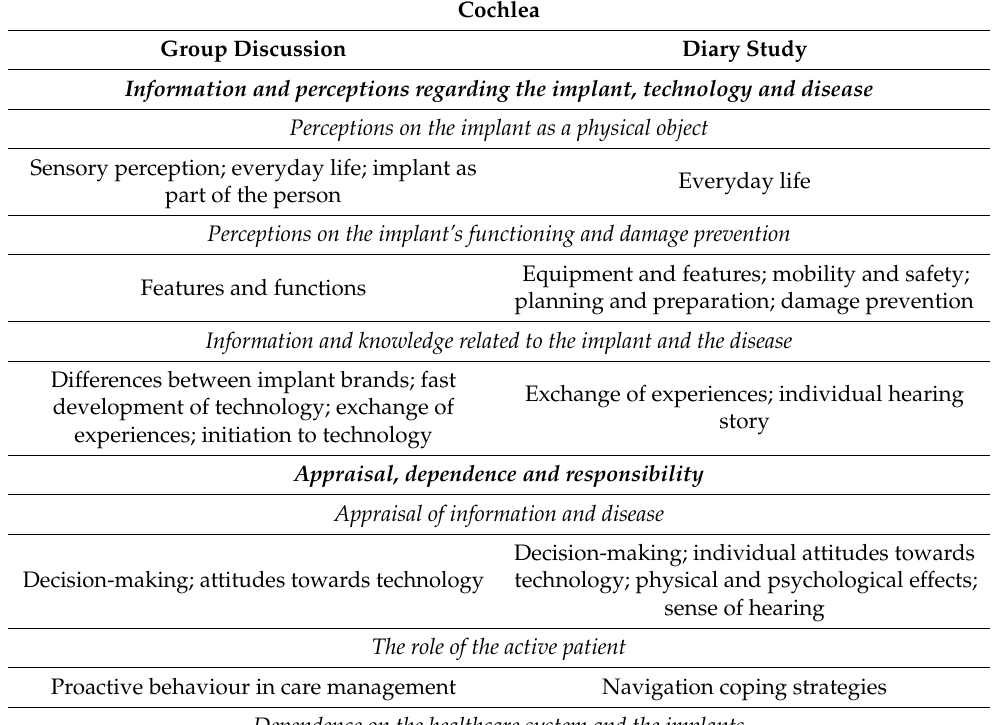
Table A3. Structure of the collective orientation patterns of GD and